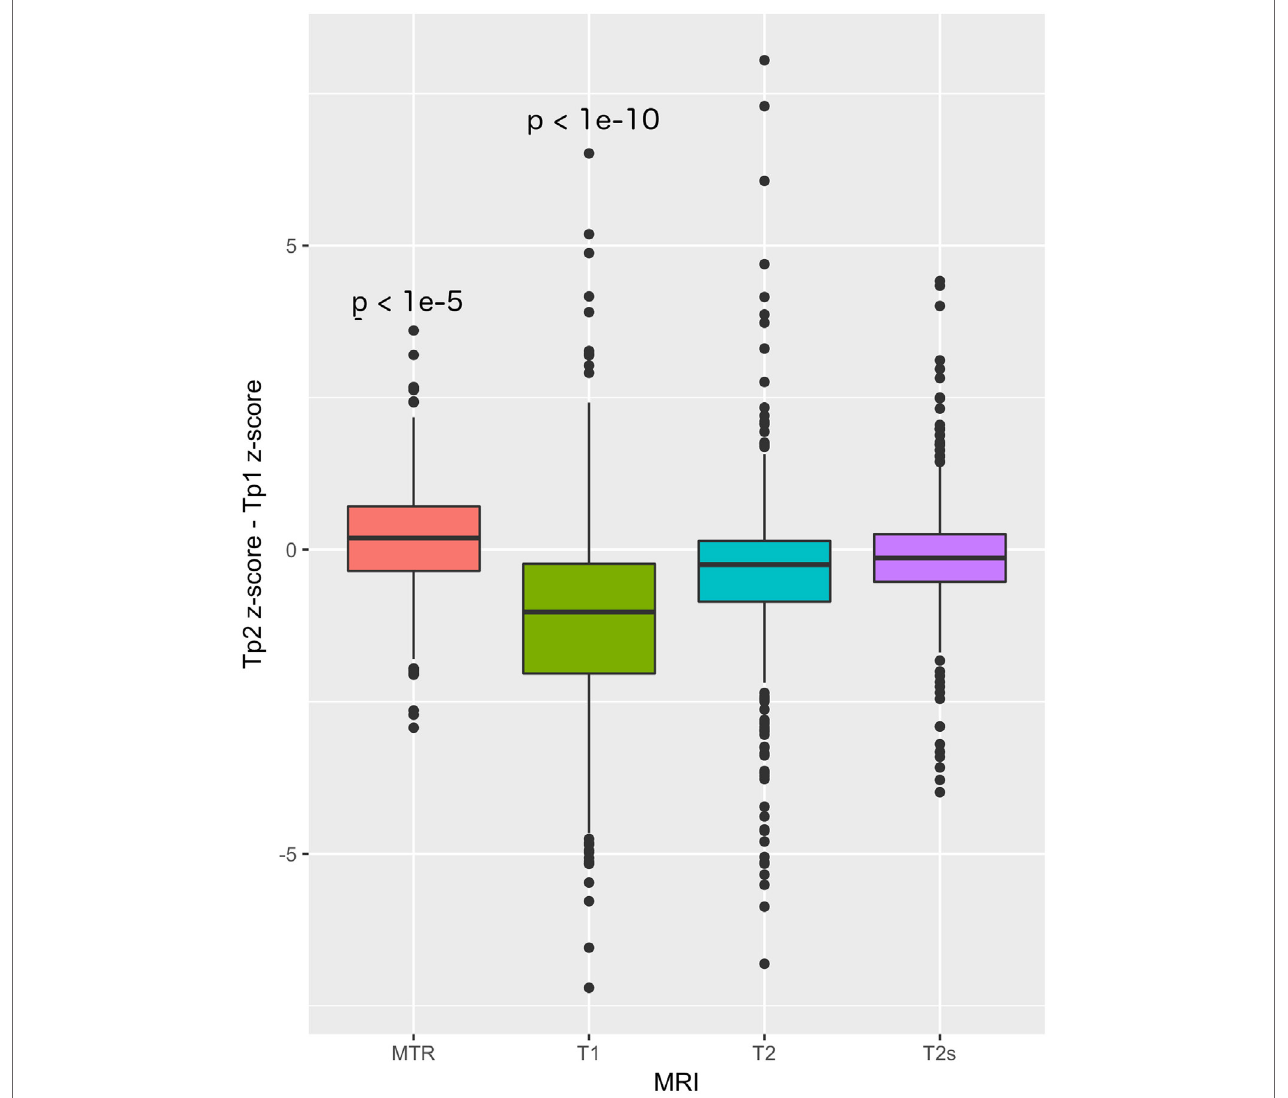
FigUre 4 | T1, T2, T2*, and MTR z -scores differences between baseline and follow-up in MS